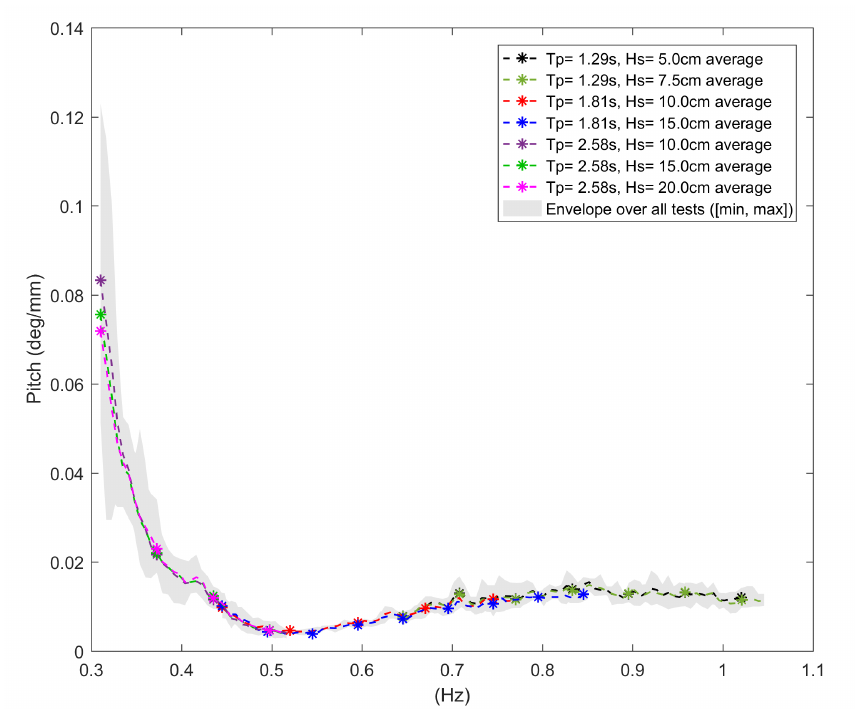
Figure 17. Pitch RAOs for all JONSWAP waves: average and envelope (min and